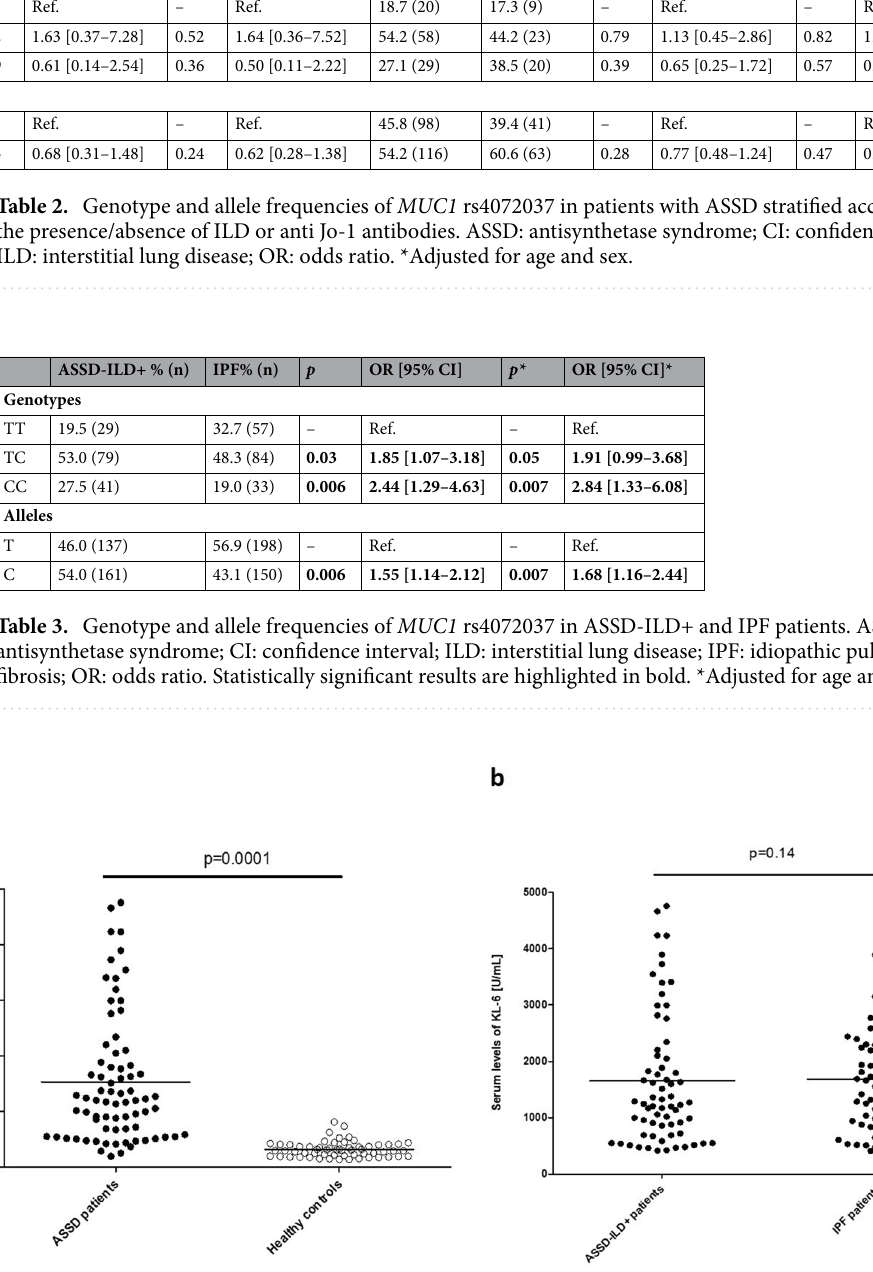
Figure 1. Serum KL-6 levels in patients with antisynthetase syndrome (ASSD), healthy controls and patients with idiopathic pulmonary fibrosis (IPF). ( a ) Comparison between ASSD patients and healthy controls. ( b ) Comparison between patients with ILD associated with ASSD (ASSD-ILD+) and IPF patients. P values were adjusted for age, sex, and smoking history. Horizontal bars indicate the mean value of each study